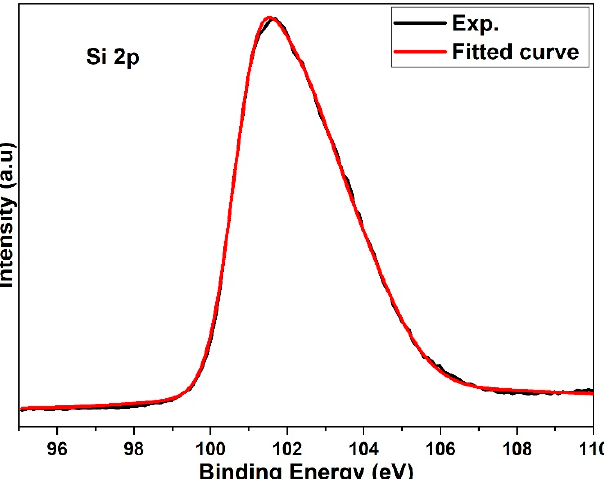
Figure 8. XPS spectrum of Si p2 of 3C-SiC nanoparticles from the surface of the crystalline and gaussian fitting represented by dashed line.